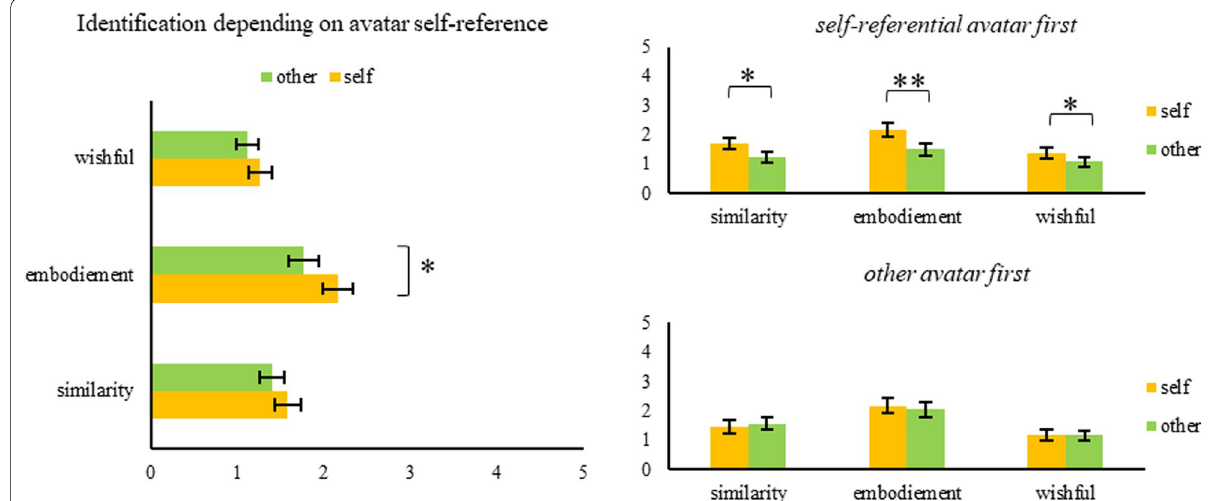
Fig. 7 Player Identification Scale results for all participants that submitted valid data and split by the order in which the SSG was played (top right: self-referential avatar first, bottom right: other avatar first). * p < .05, ** p < .001. Error bars signify the standard error of the